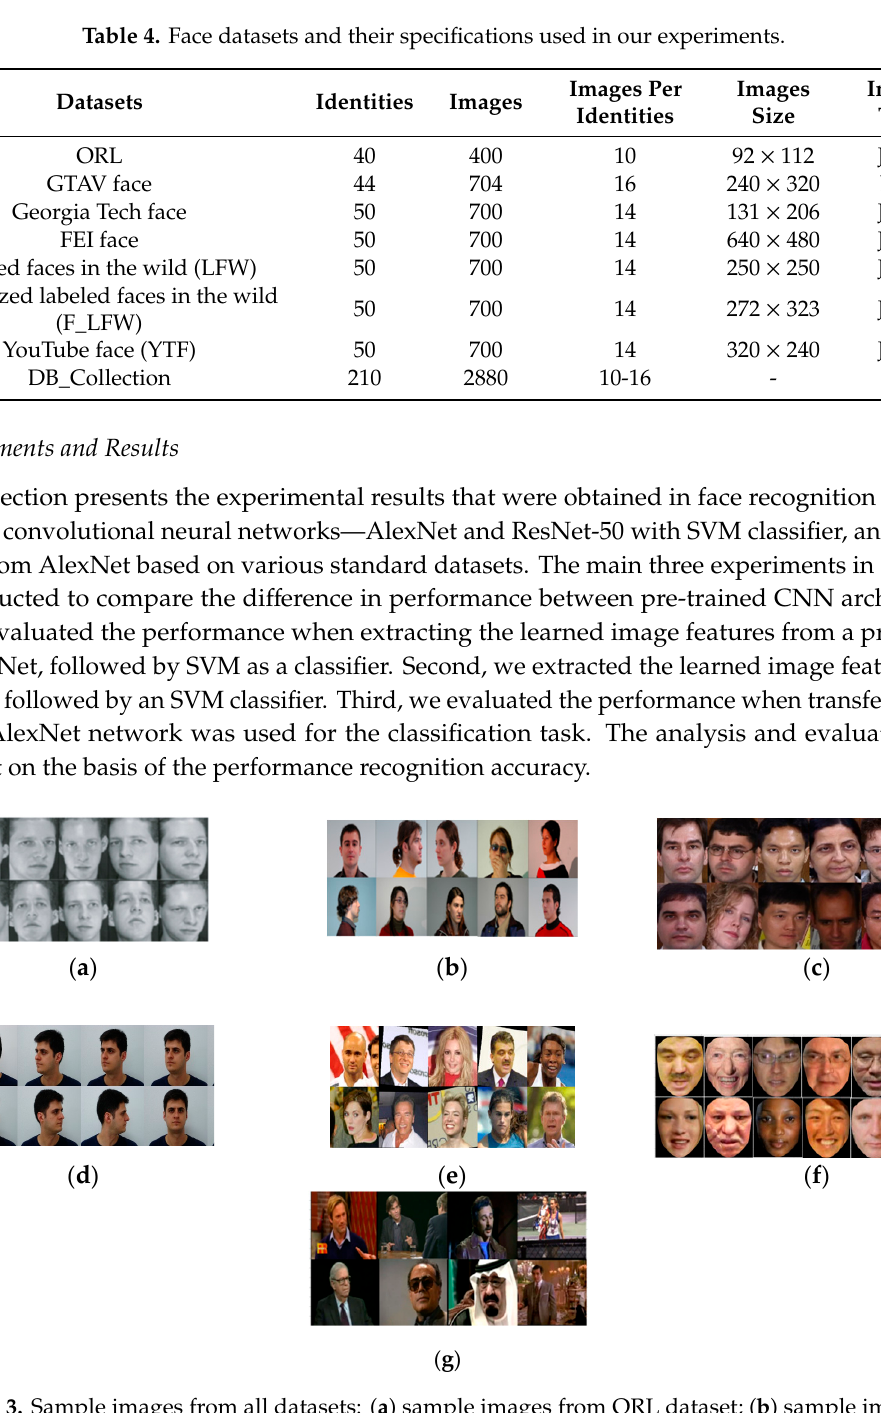
Figure 3. Sample images from all datasets: ( a ) sample images from ORL dataset; ( b ) sample images from GTAV face dataset; ( c ) sample images from Georgia Tech face dataset; ( d ) sample images from FEI dataset; ( e ) sample images from LFW dataset; ( f ) sample images from F_LFW dataset; ( g ) sample images from YTF